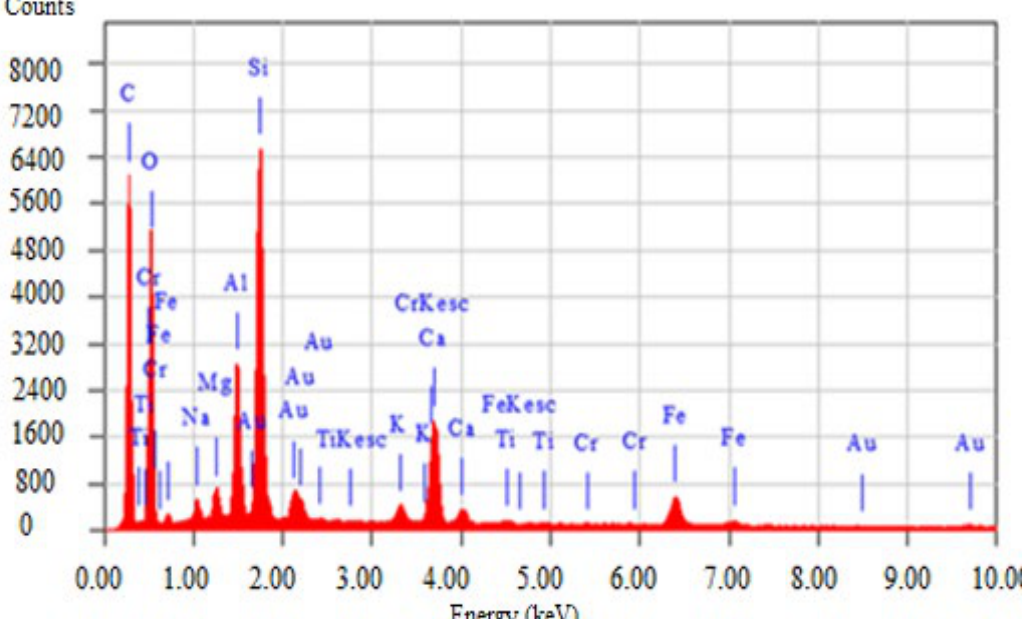
Figure 12. Elemental analysis of the fired ceramic sample with the addition of 25% spent sorbent after firing. Table 9. Average chemical composition of the fired samples.